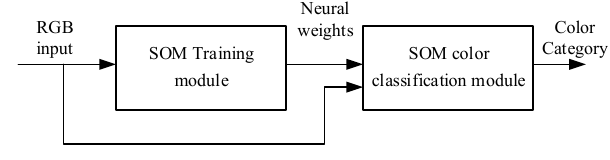
Figure 5. SOM-based image segmentation module.